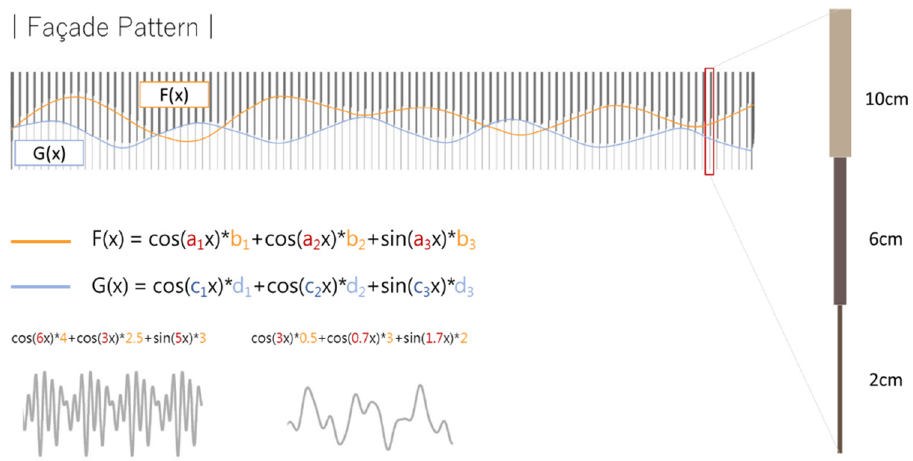
Figure 4. The concept of façade design (Participant A).